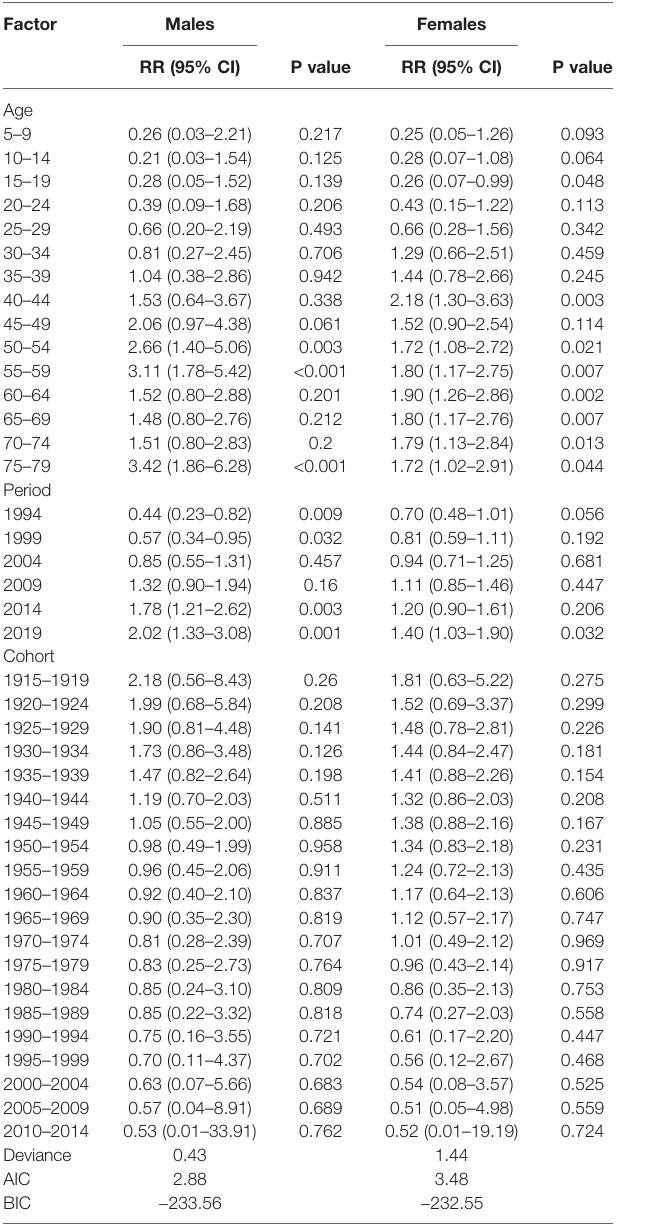
TABLE 2 | Sex-speci fi c relative risks of thyroid cancer incidence in China due to age, period, and cohort effects. Factor